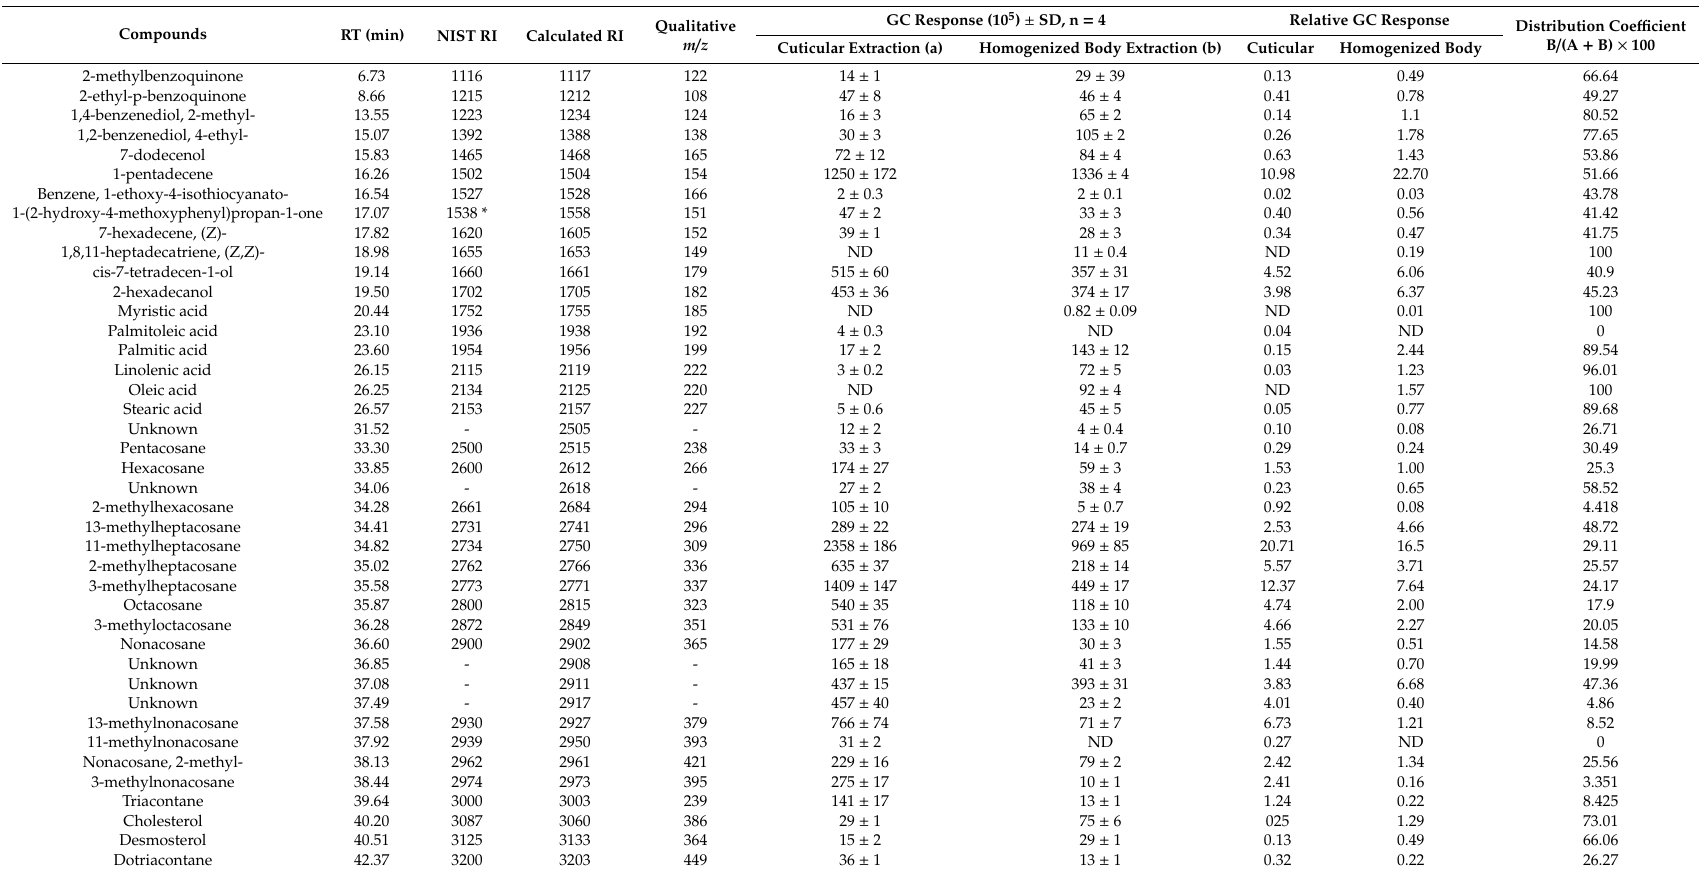
Table 3. Extracted and identified compounds from the cuticle layer and homogenized body of T. castaneum in acetonitrile. GC Response (10 5 ) ± SD, n = 4 Relative GC Response Compounds RT (min) NIST RI Calculated RI Qualitative m / z Homogenized Body Extraction (b) Cuticular Homogenized Body